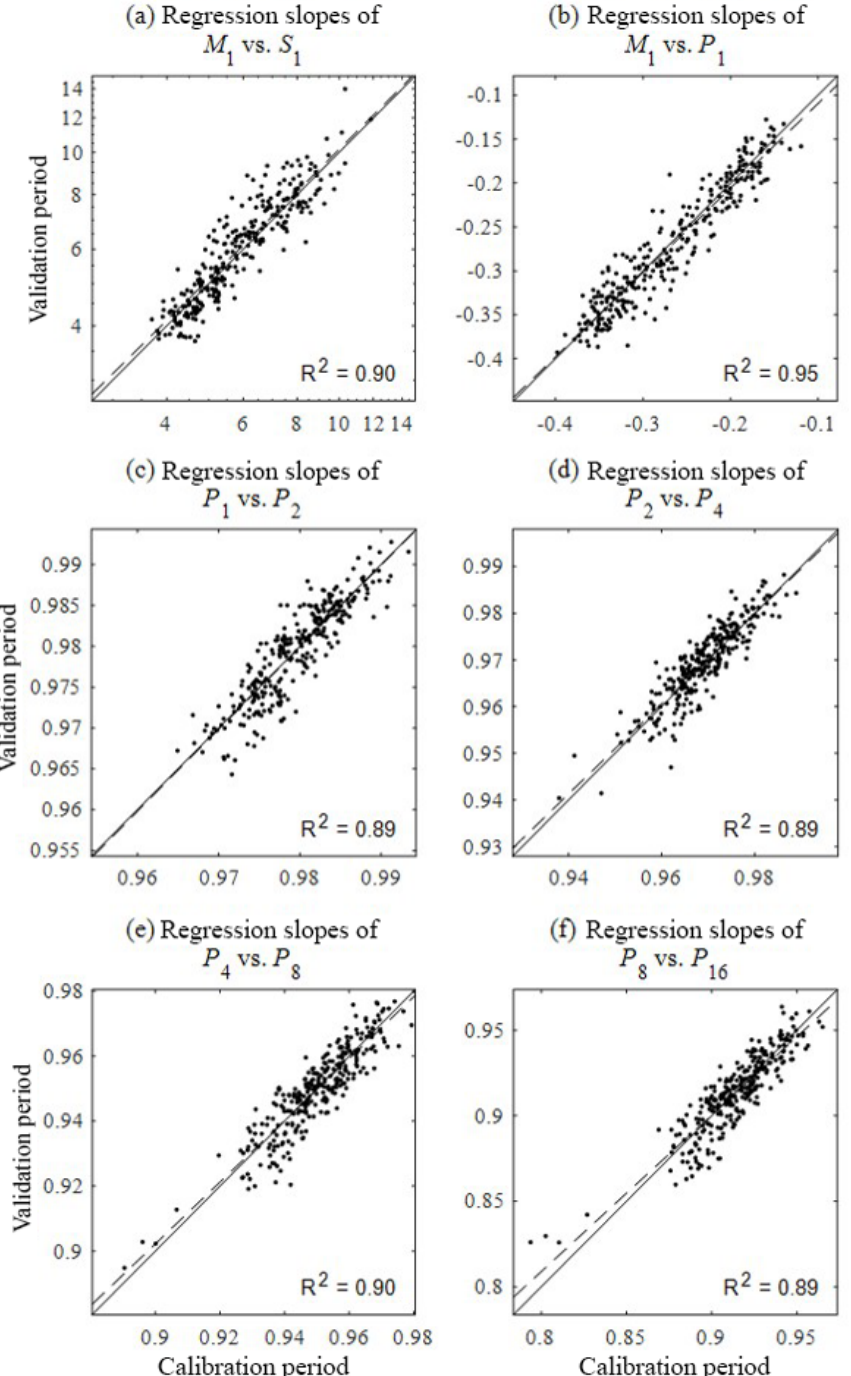
Figure 19. Comparison of the slope of regression analysis between the statistics shown in Fig. 6 for the calibration ( x ) and validation ( y ) period. The slopes of regression analysis (a) between the mean and standard deviation, (b) between the mean and proportion of dry periods, and (c–f) between the proportion of dry periods at the different timescales were compared. Solid lines are 1 : 1 line and dashed lines represent the regression